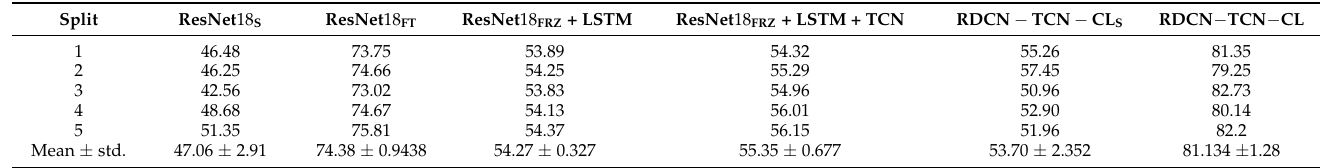
Table 5. Comparison between RDCN − TCN − CL and other network architectures in terms of retrieval performance (mAP ± std.) on Cataract-101 under the CB-SVR system.